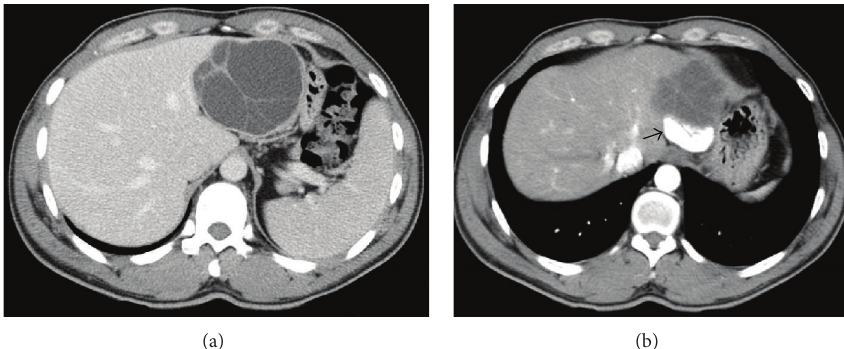
Figure 1: Enhanced computed tomography of the abdomen revealed a large cystic lesion, 9 cm in diameter, in the lateral segment of the liver, which has many honeycomb-like septa (a) with calcified lesions (b arrow).